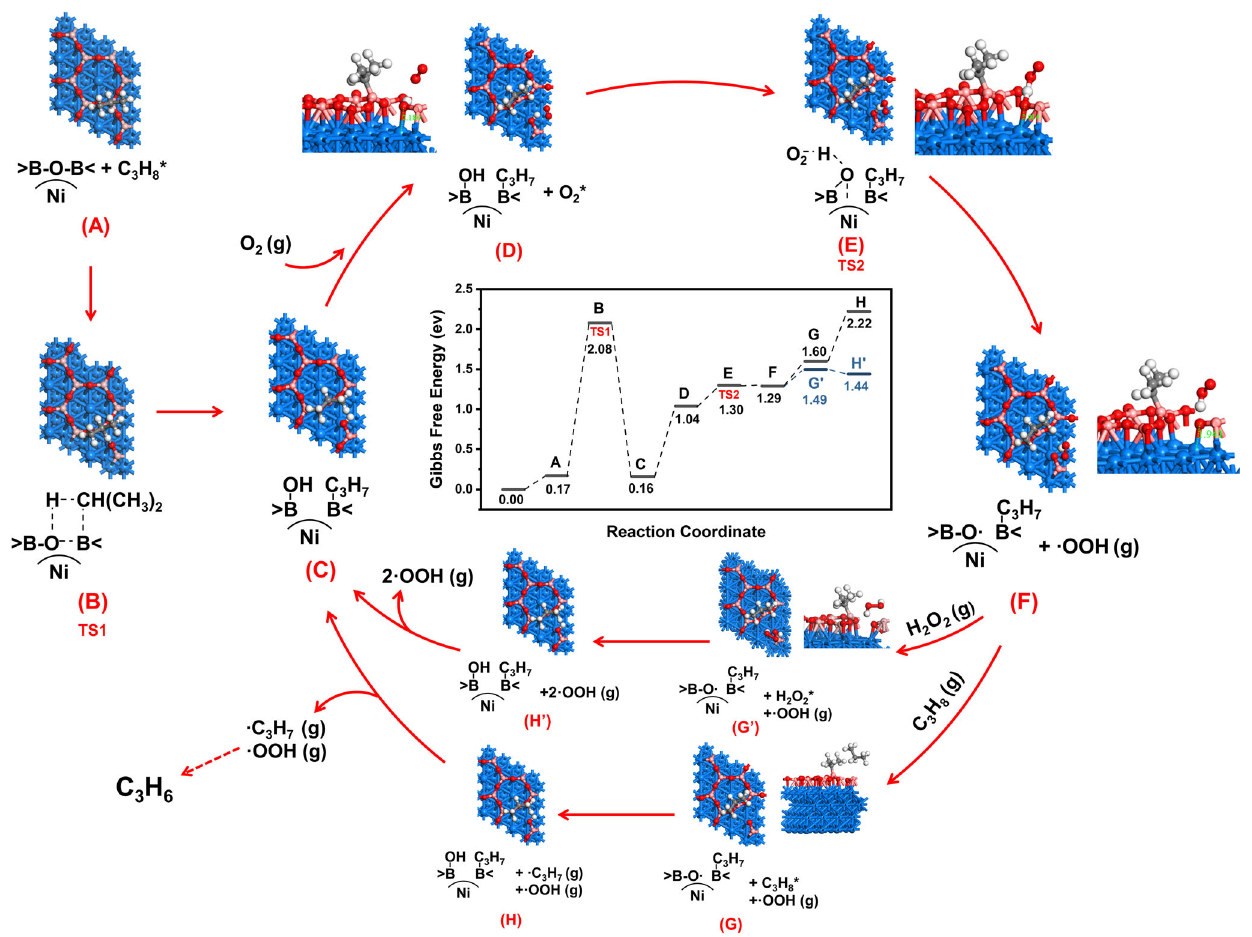
Fig. 4 | DFT calculation of the ODHP reaction pathway on the B 2 O 3 /Ni(111) model surfaces. The activation of the active site is shown from state A to state C. StatesCtoH(H')illustratethecatalyticcyclesoftheODHPreactions.Thelightblue,